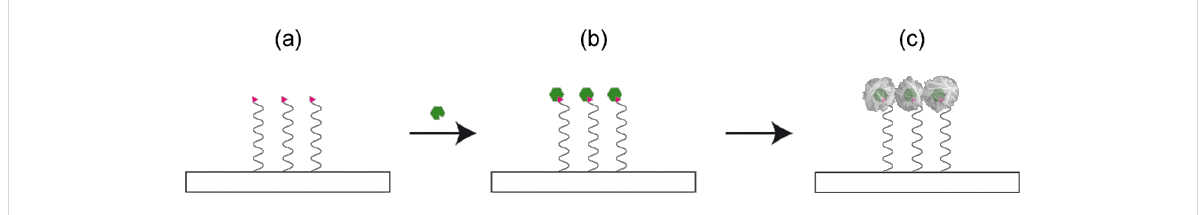
Figure 1: Schematic sketch displaying the growth mechanism of the silver EGNP: (a) the substrates are immobilized with single-strand DNA as linker molecules; (b) this is followed by binding of HRP at the target DNA; (c) finally the growth of the nanoflower-like silver nanoparticles is induced by the